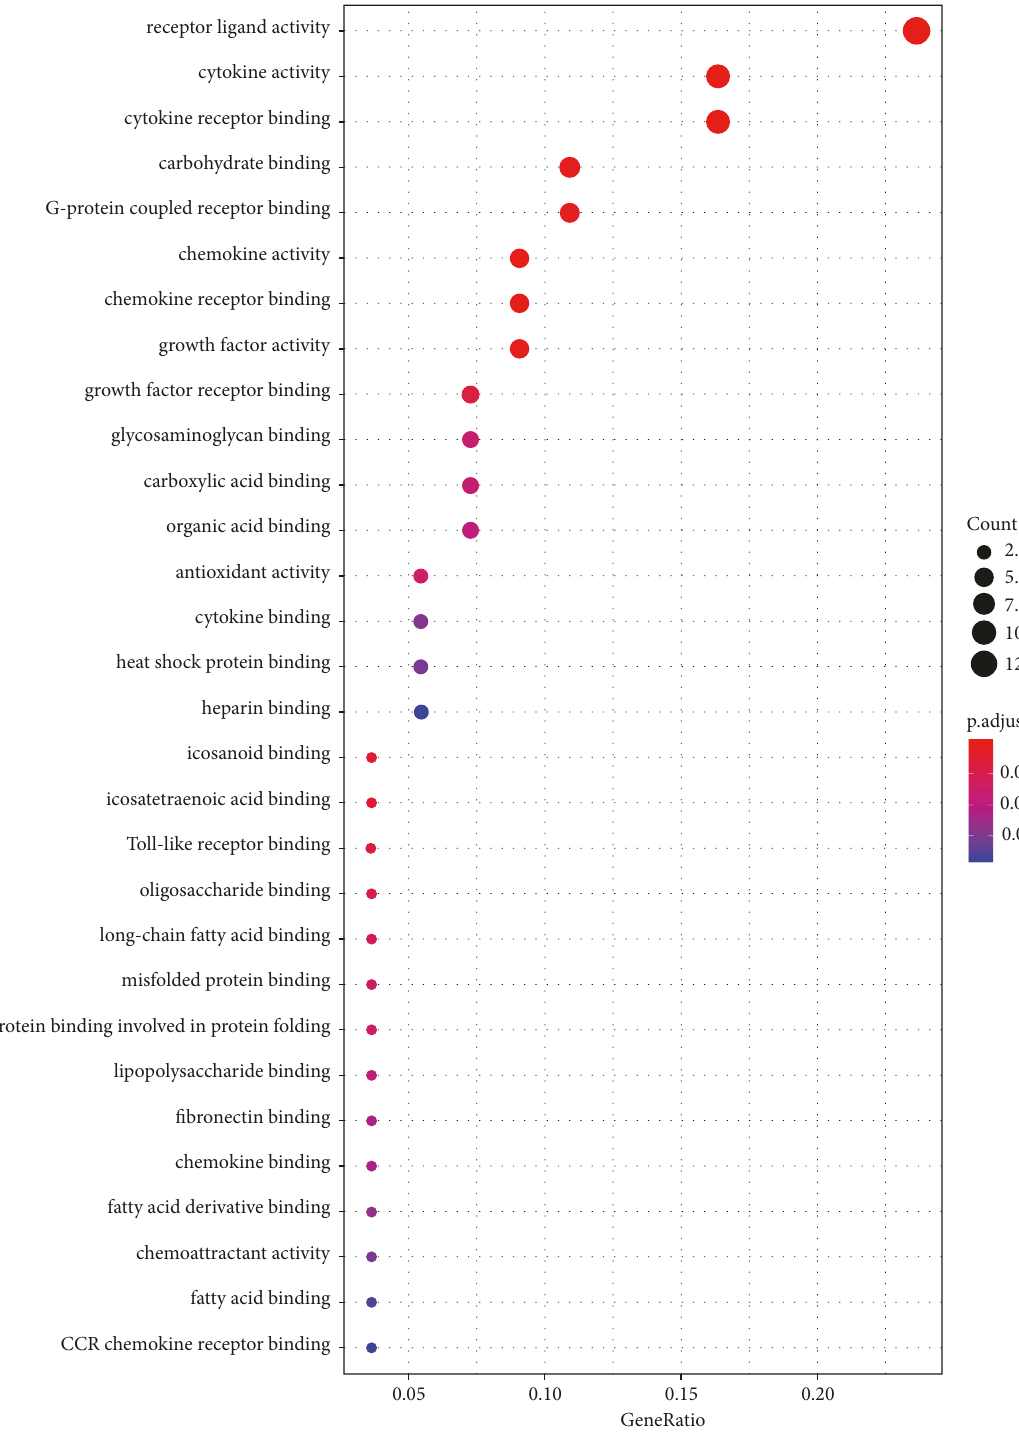
Figure 4: GO enrichment analyses of DEGs in AMI. Notes: X-axis indicates the percentage that each functional group gene, respectively, accounts for the total genes. Y-axis represents different functional groups (also named as different GO terms). The size of the dot indicates the number of genes in different functional groups, and the color of the dot reflects the different p -value range. The bigger the gene count, the bigger the dot size is. The gradual color ranged from blue to red represents the changing process of p -value from big to small value. Abbreviations: AMI, acute myocardial infarction; DEGs, differentially expressed genes; GO, gene